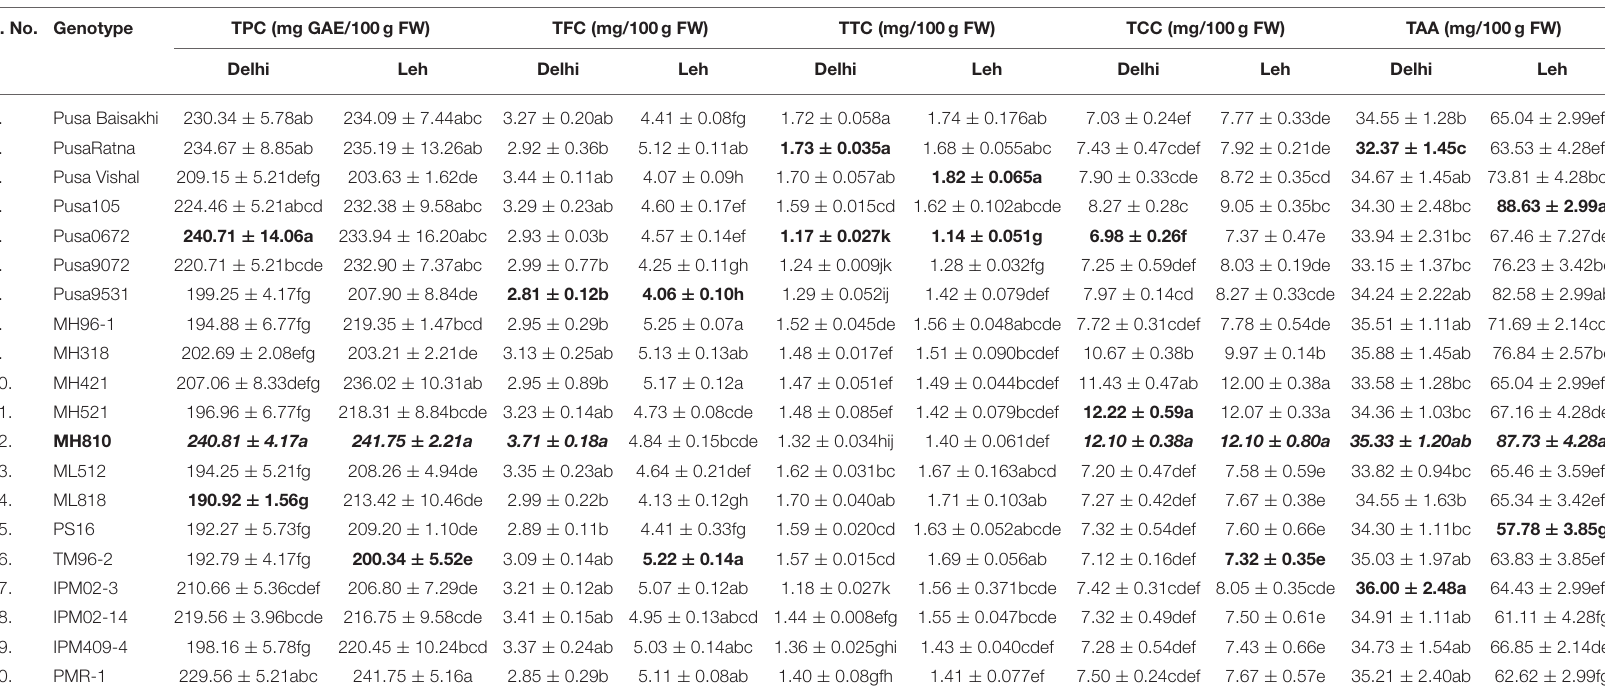
TABLE 1 | Mean concentration of total phenolics, flavonoids, carotenoids, tocopherols, and ascorbic acid in mungbean microgreens grown under Delhi and Leh